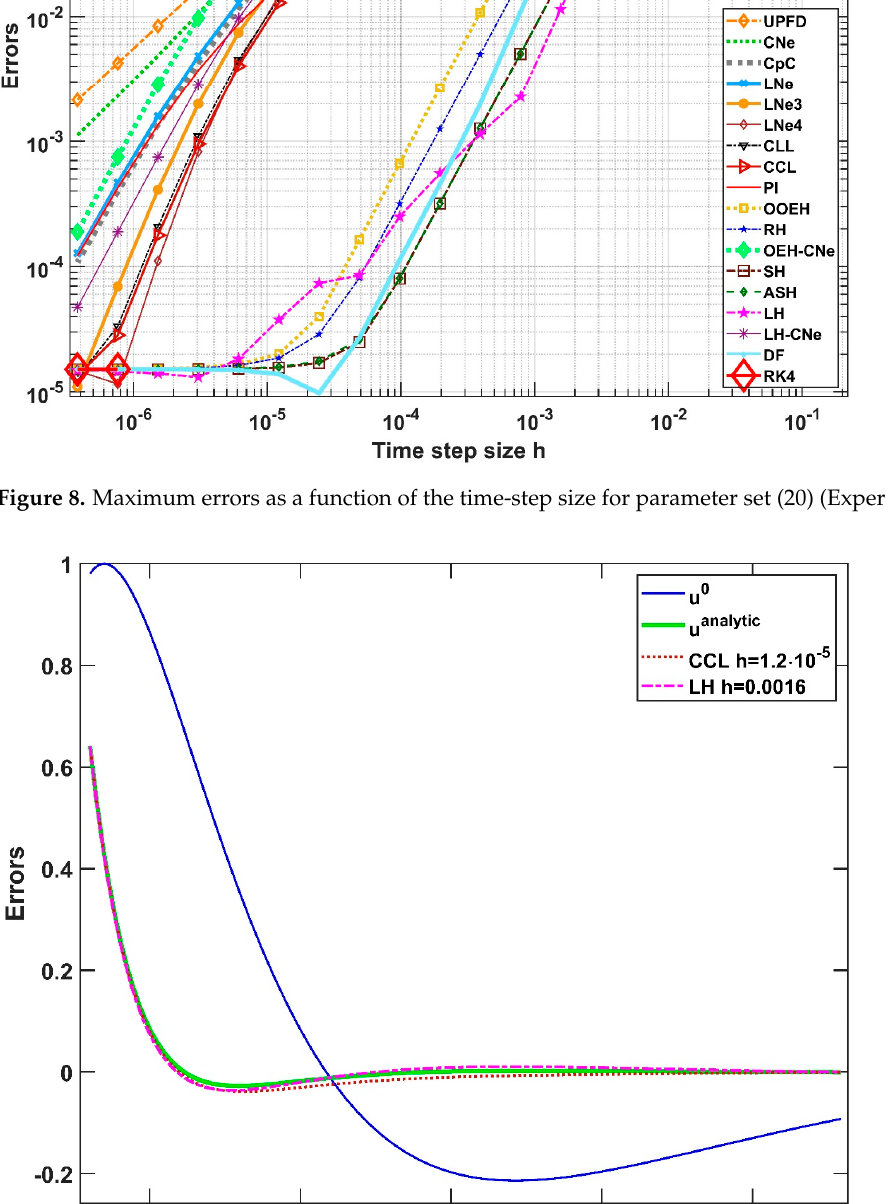
Figure 10. The time development of the errors, i.e., the absolute di ff erence between the analytical solution and that of the stable numerical methods, for 3 10 h − = as a function of time.